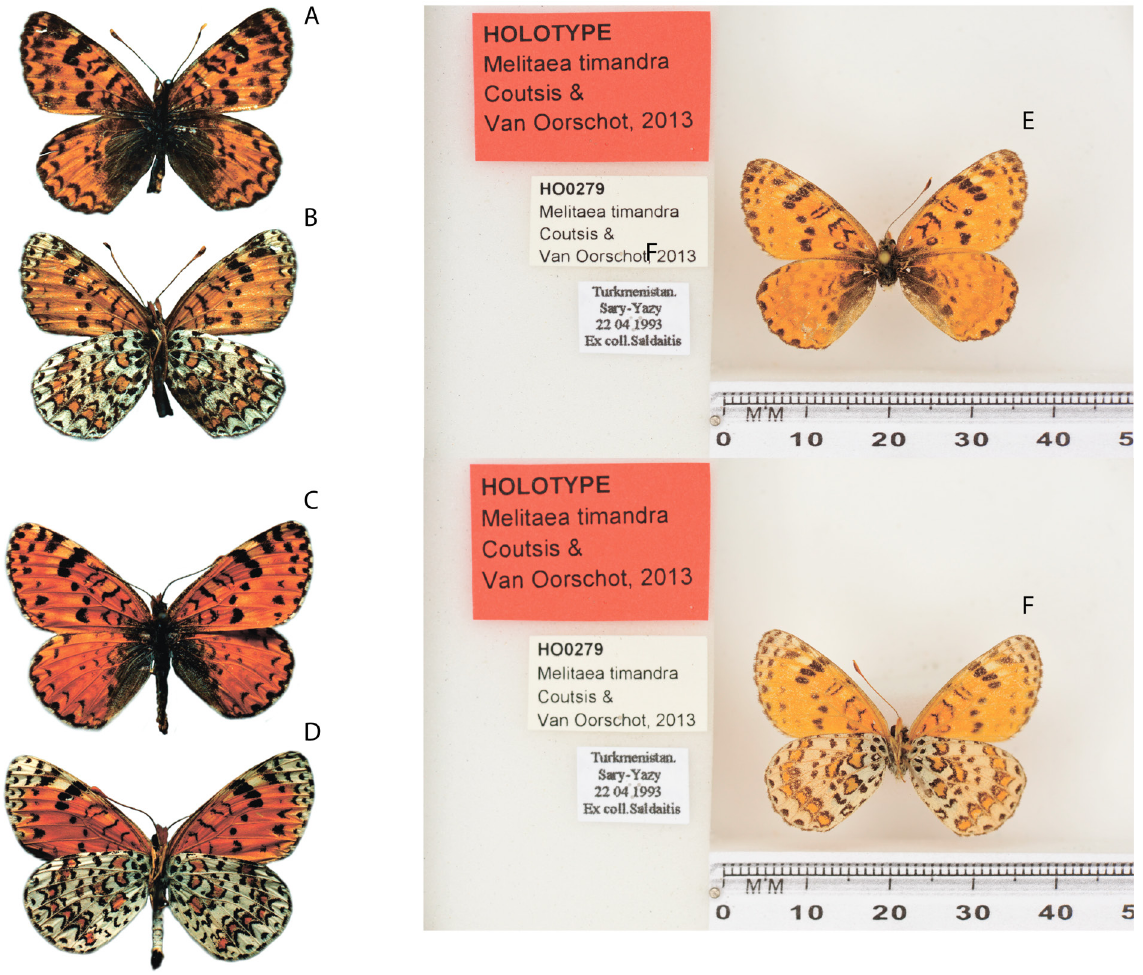
Fig. 1. Type specimens of M. lutko Evans, 1932, M. mimetica Higgins, 1940, and M.